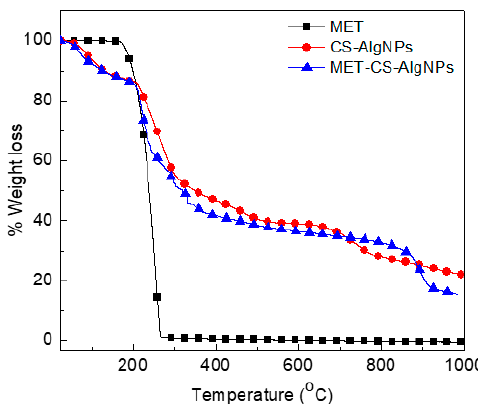
Figure 12. TGA curves of MET, CS-AlgNPs and MET-CS-AlgNPs nanocomposites. 392